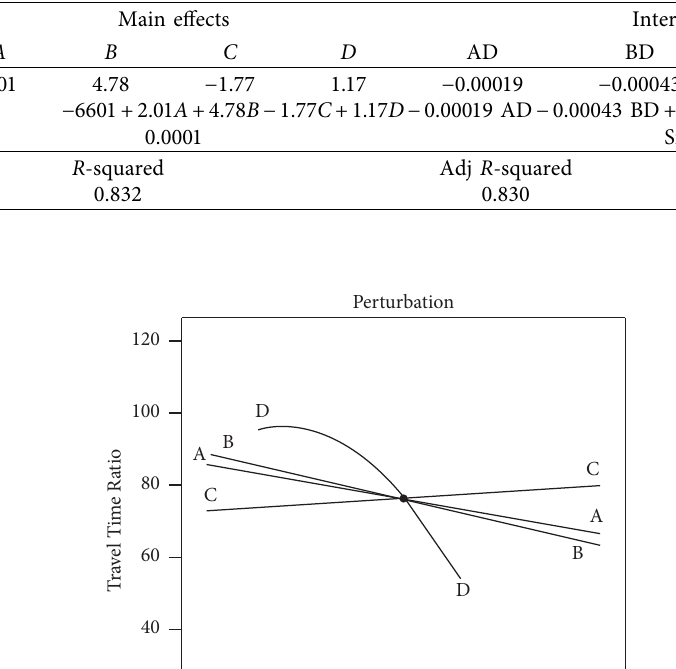
Table 9: Efect of decrease in trafc violations and trafc volume on travel time ratio.